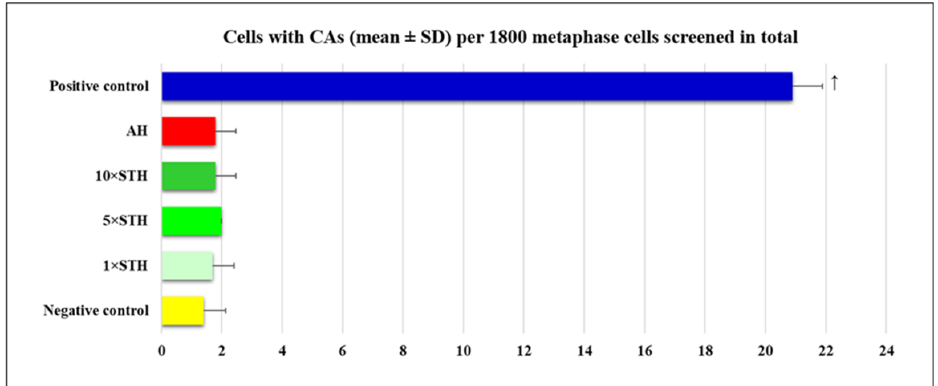
Figure 1. Incidence of cells with CAs observed after treatment with strawberry tree honey (STH) and artificial honey (AH). Negative control (non-treated cells) and positive control (bleomycin—15 mg/L) groups were studied in parallel. Significantly increased value ( p < 0.05) is ↑ —vs. all other experimental groups. Table 1. Results of CA assay on human lymphocytes after treatment with strawberry tree honey (STH) and artificial honey (AH). Negative control (non-treated cells) and positive control (bleomycin— 15 mg/L) groups were studied in parallel.